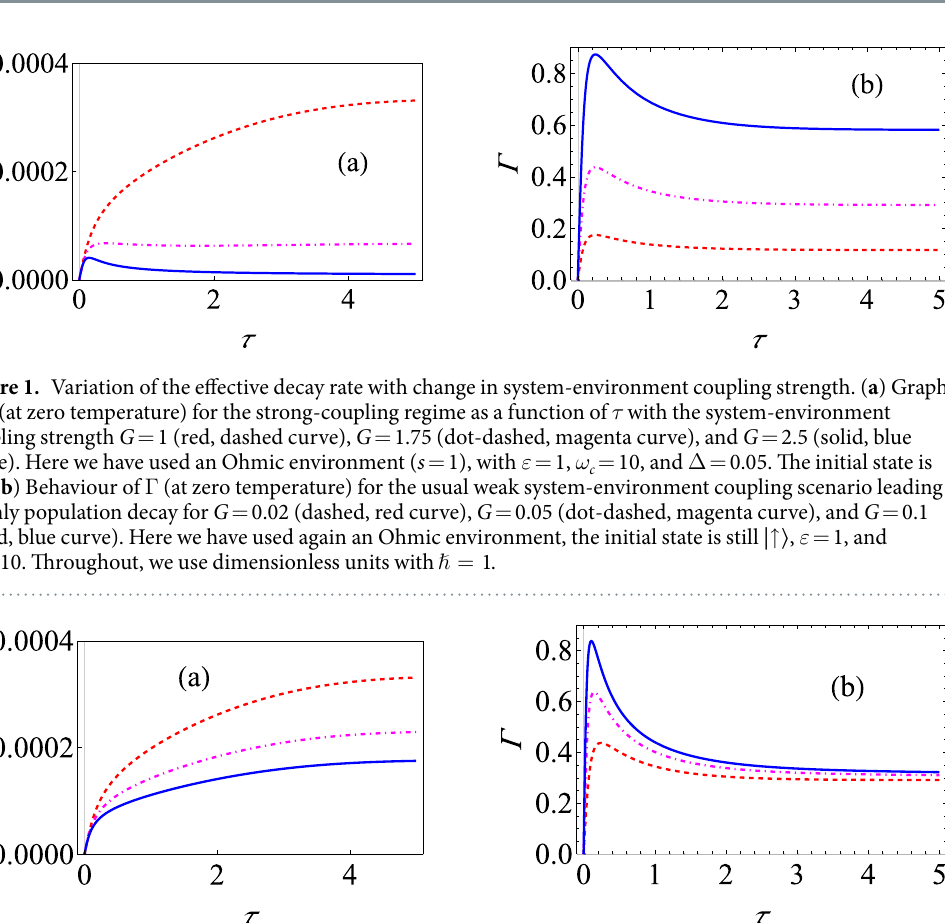
Figure 2. Variation of the effective decay rate with change in the cutoff frequency. ( a ) Graph of Γ (at zero temperature) for the strong-coupling regime as a function of τ with ω = 10 (red, dashed curve), ω = 15 (dot- c c dashed, magenta curve), and ω = 20 (solid, blue curve). Here we have used an Ohmic environment ( s = 1), c with ε = 1 , G = 1, and Δ = 0.05. The initial state is | ↑ 〉 . ( b ) Behaviour of Γ (at zero temperature) for the usual weak system-environment coupling scenario leading to only population decay for ω = 10 (red, dashed curve), c ω = 15 (dot-dashed, magenta curve), and ω = 20 (solid, blue curve). Here we have used again an Ohmic c c environment, the initial state is still | ↑ 〉 , ε = 1 , and G =